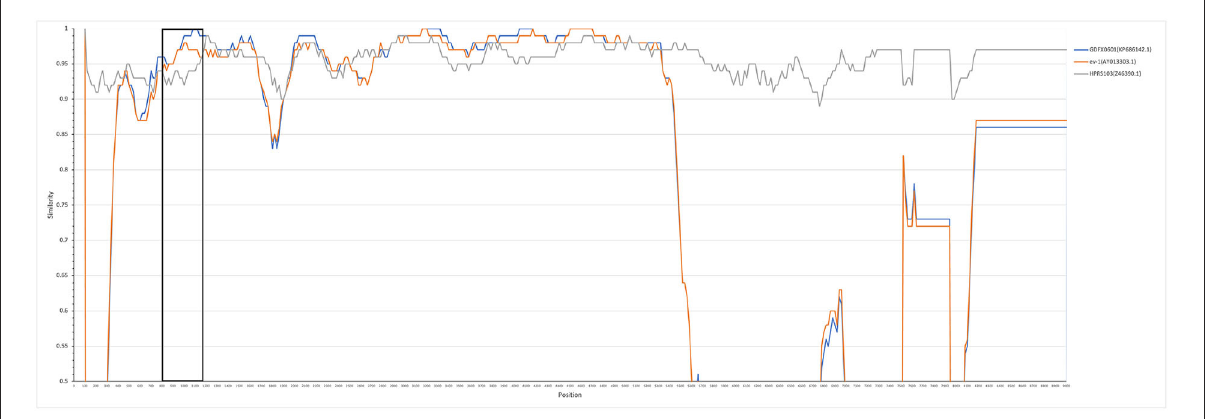
FIGURE5 HB2020 recombination analysis SimPlot software (V3.5.1) was used to analyze recombination events, which were then mapped using the Kimura (2-parameter) model. The reliability of the recombination event was assessed using a 100-bootstrap, and a parental threshold of > 70% was chosen as the cut-off value.